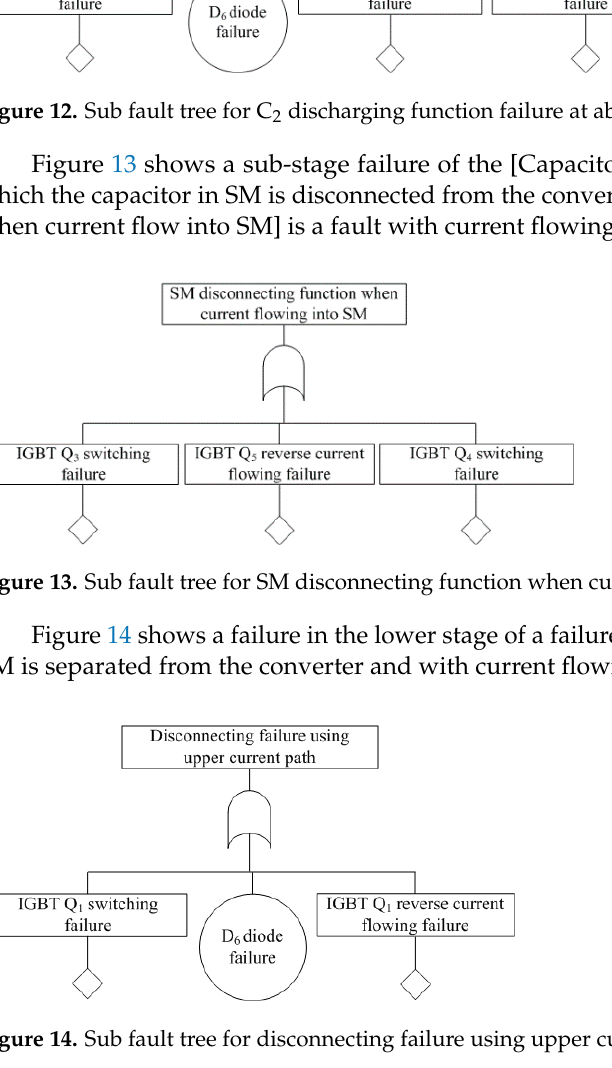
Figure 11. Sub fault tree for C 2 discharging function failure at normal mode. Figure 12. Sub fault tree for C 2 discharging function failure at abnormal mode.